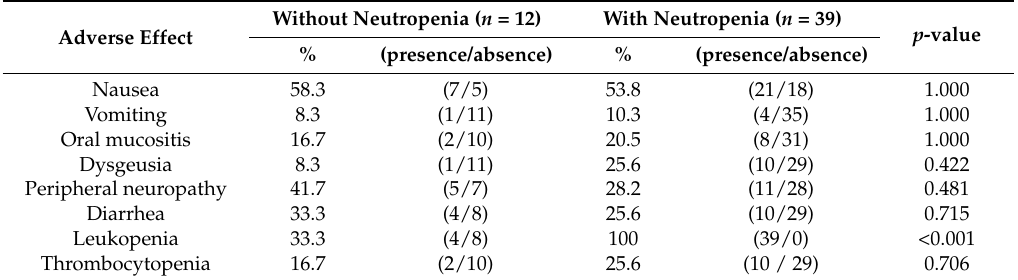
Table 6. Comparison of the incidence of other adverse events (grade ≥ 2) between patients with and without grade ≥ 3